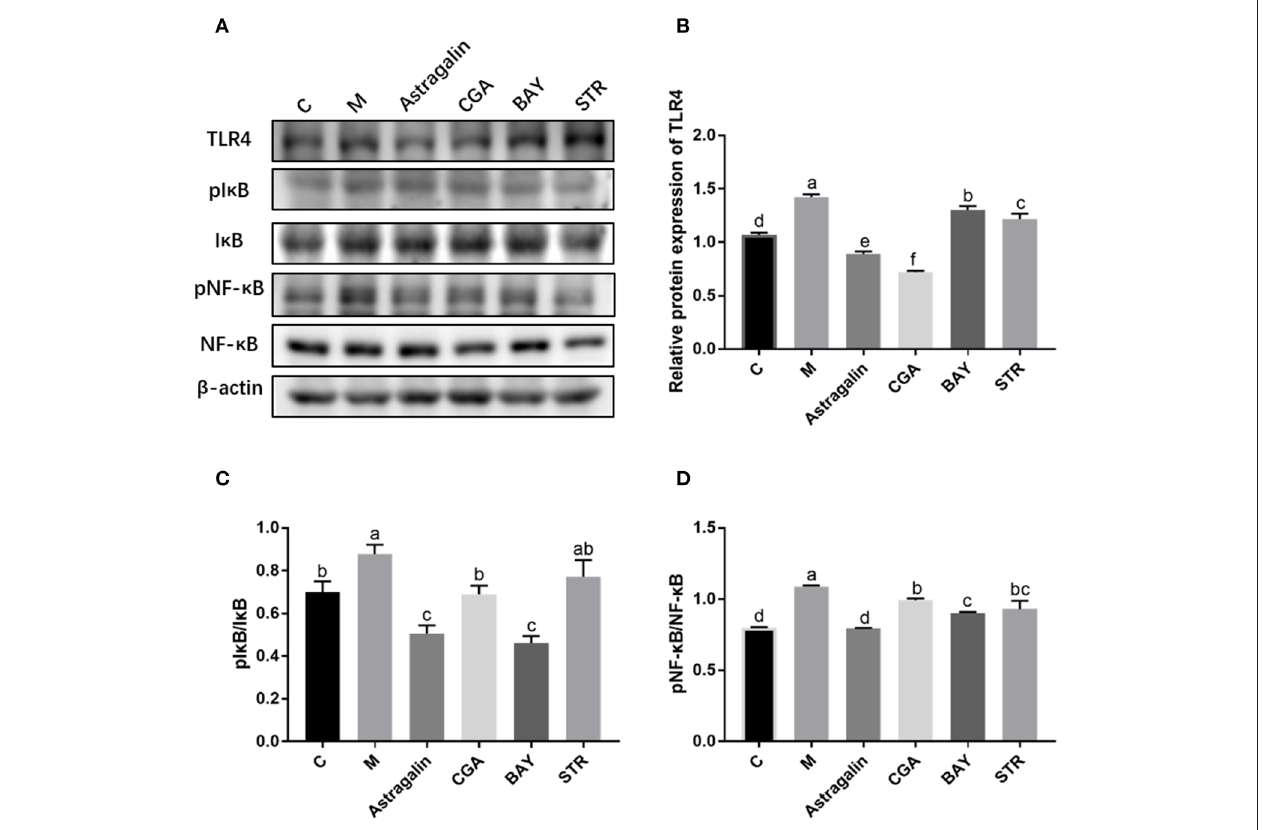
FIGURE 9 | The relative protein expression of genes in the TLR4/NF- κ B pathway. The SEECs were pretreated for 3h with various medicines (astragalin, CGA, BAY, and STR) and then exposed to E. coli for 3h, and the protein levels of TLR4, pI κ B, I κ B, pNF- κ B, and NF- κ B were determined by western blot analysis. (A) The protein bands of TLR4, pI κ B, I κ B, pNF- κ B, NF- κ B, and β -actin detected by western blot. (B) The IntDen of TLR4/ β -actin. (C) The IntDen of pI κ B α /I κ B α . (D) The IntDen of pNF- κ B/NF- κ B. Data are represented as the mean ± SD of three independent experiments with mixed SEECs from 15 sheep. Values with different lowercase letters were considered as statistically significant ( P <